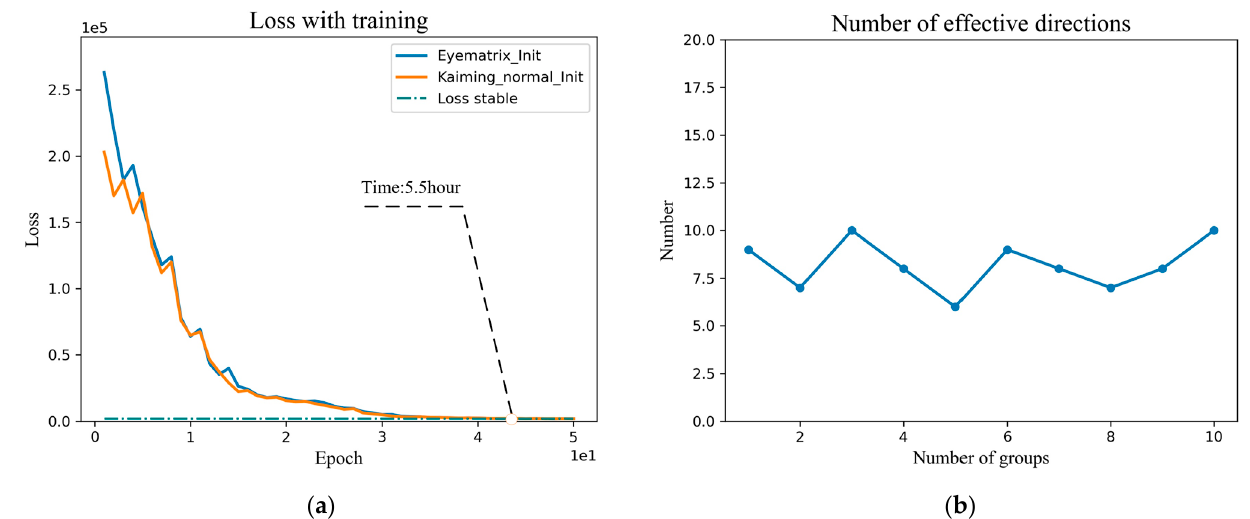
Figure 4. ( a ) Training time of Jacobi orthogonal regularization search with different initialization methods. ( b ) The proportion of effective directions obtained by Jacobi orthogonal regularization search method.